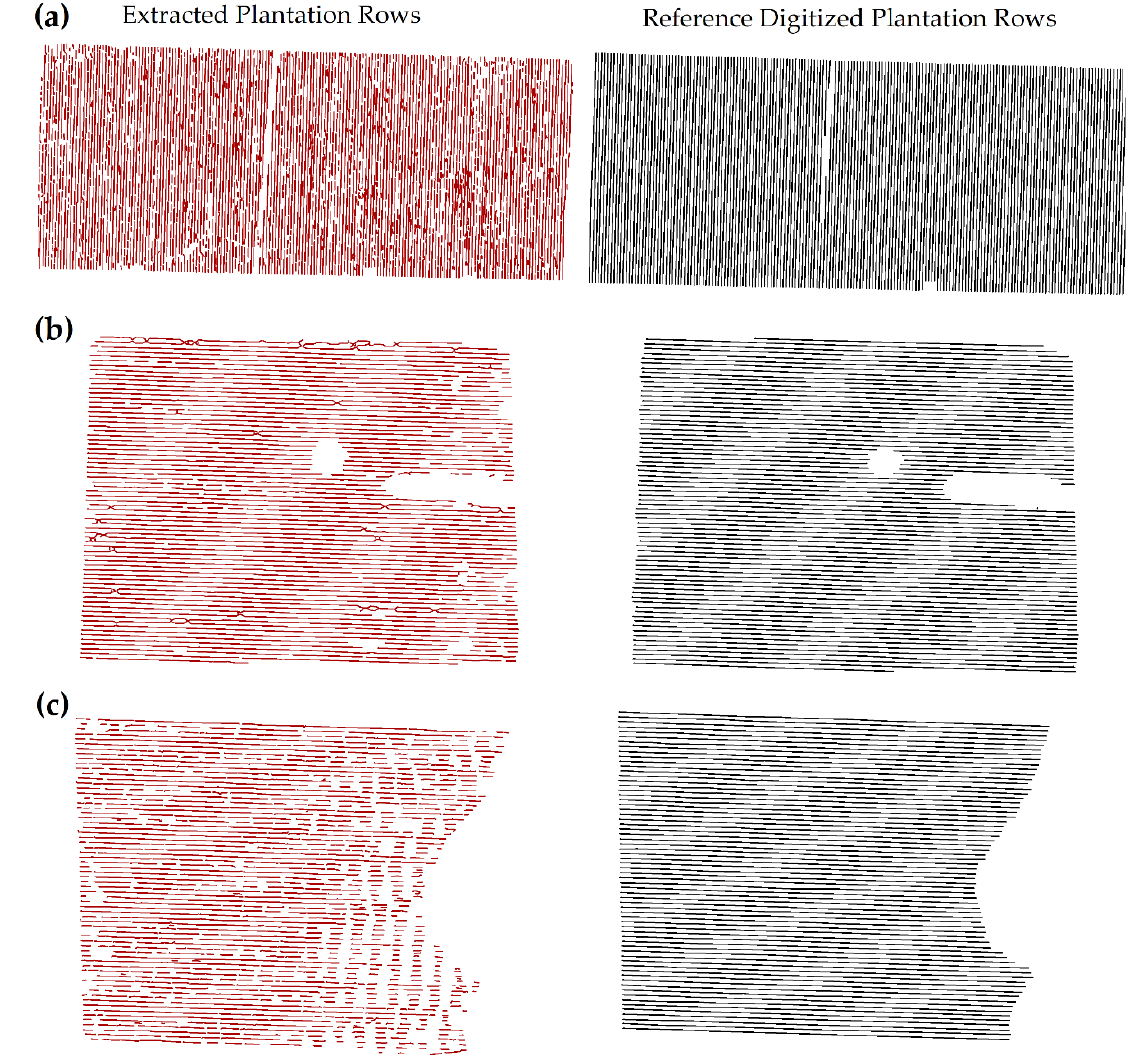
Figure 16. Plantation-rows: ( a ) compartment-A, plantation rows extracted from DIPC-based DSM; ( b ) row extraction for compartment-B; ( c ) extracted plantation rows for compartment-C. The grey lines represent the reference data of plantation rows digitized from the Orthomosaic.